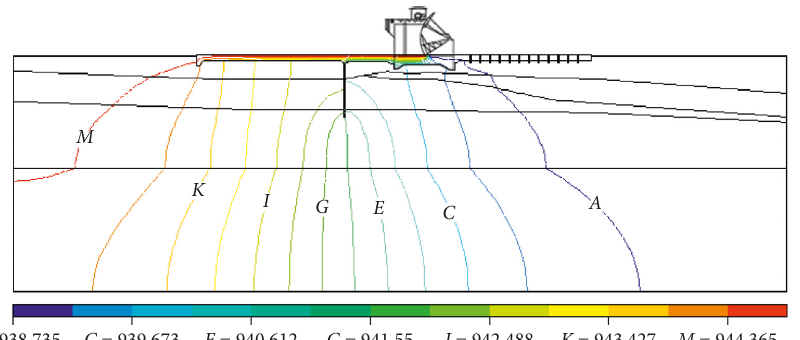
Figure 22: Total seepage head contour in 2# sluice foundation in flood season.